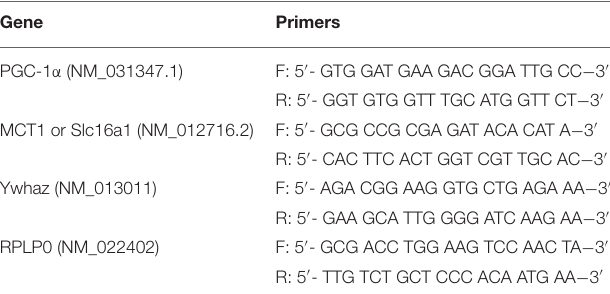
C = concentration in recirculating buffer, HW = heart weight, t = time point of interest, V = buffer volume.